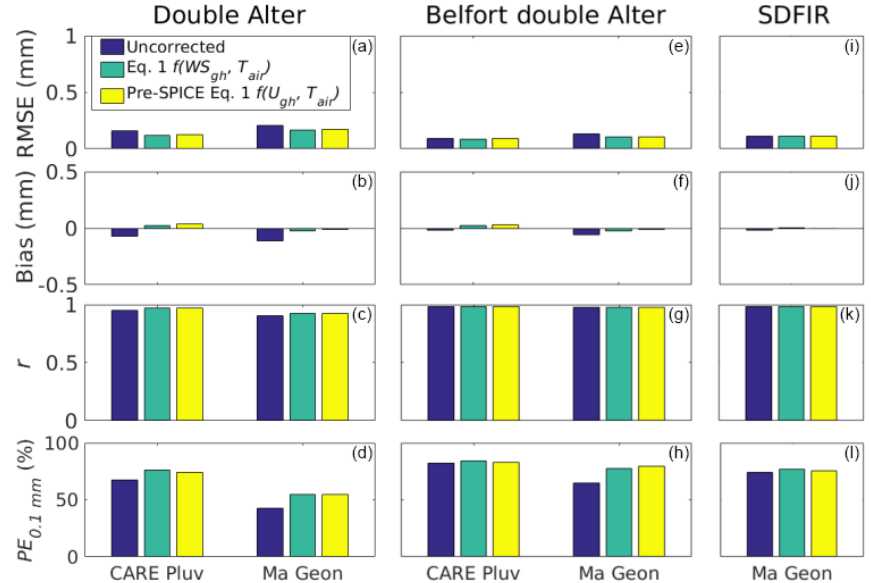
Figure 6. Error statistics calculated from the double-Alter shielded Pluvio 2 gauge at CARE (Care Pluv, a–d ), the double-Alter shielded Geonor at Marshall (Ma Geon, a–d ), the Belfort double-Alter shielded Pluvio 2 at CARE (CARE Pluv, e–f ), the Belfort double-Alter shielded Geonor at Marshall (Ma Geon, e–h ), and the SDFIR shielded Geonor at Marshall (Ma Geon, i–l ). The different adjustment types are described in the Fig. 4 caption. Statistics describing these measurements adjusted using the appropriate pre-SPICE transfer functions from K2017b are also shown (Pre-SPICE, Eq. 1,